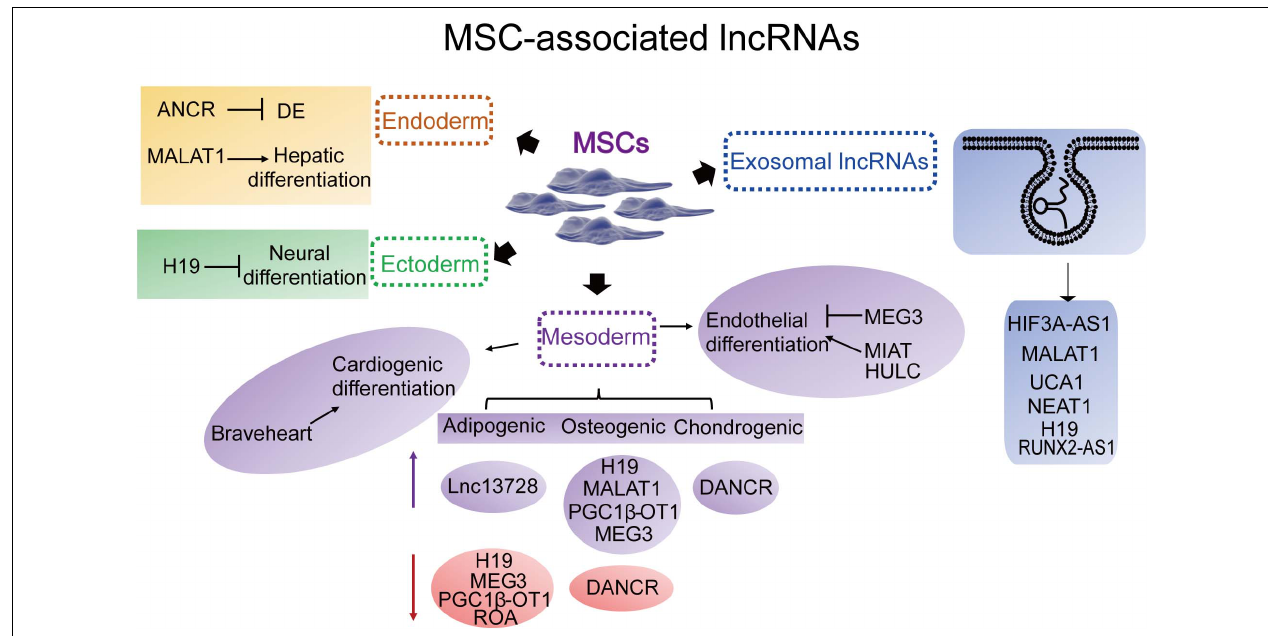
FIGURE 3 | Representative MSC differentiation- and exosome-associated lncRNAs. Endoderm: ANCR (DANCR), (differentiation) antagonizing non-protein coding RNA; MALAT1, metastasis-associated lung adenocarcinoma transcript 1. Ectoderm: H19. Mesoderm-cardiac: Braveheart. Mesoderm-adipogenic: PGC1 β -OT1, peroxisome proliferator-activated receptor γ coactivator-1 β -OT1; lnc13728; H19; MEG3, maternally expressed 3. Mesoderm-osteogenic: H19; MEG3; MALAT1; DANCR; PGC1 β -OT1. Mesoderm-chondrogenic: DANCR. Mesoderm-endothelial: MEG3; MIAT, myocardial infarction-associated transcript; HULC, highly upregulated in liver cancer. Exosomal lncRNAs: HIF3A-AS1, HIF3A antisense 1; MALAT1; UCA1, urothelial carcinoma-associated 1; NEAT1, nuclear paraspeckle assembly transcript 1; H19; KLF3-AS1, KLF3 antisense